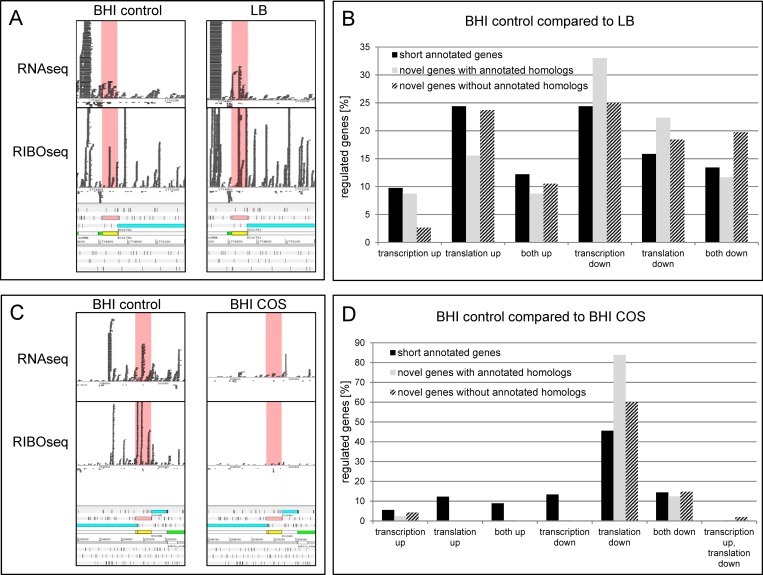
Differentially regulated genes under different growth conditions.(A) Example of a transcriptionally and translationally upregulated gene in LB compared to BHI control. The novel gene XECs170 is highlighted in pink. The transcription of XECs170 is increased 2.7-fold and translation 9.8-fold. (B) Summary of differentially regulated genes in LB compared to BHI control. For all three gene categories, downregulation dominates. (C) Example of a transcriptionally and translationally downregulated gene in BHI COS compared to BHI control. Transcription of XECs197 is 5.5-fold and translation is 129-fold reduced at the stress condition. (D) Summary of differentially regulated genes in BHI COS compared to BHI control. Downregulation at the translational level clearly dominates for all gene categories.